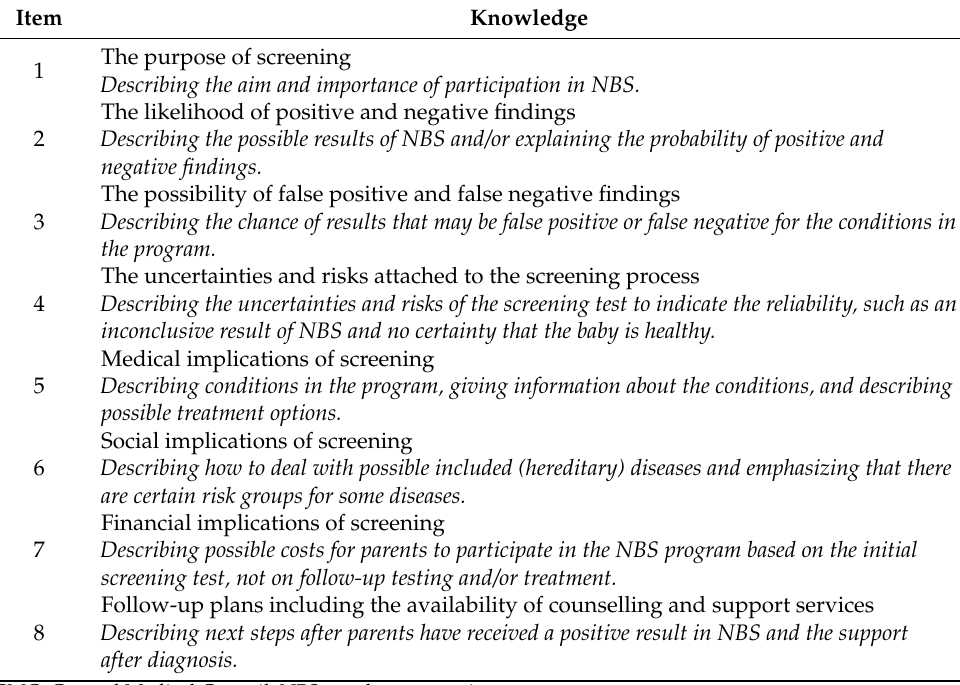
Table 1. Knowledge aspects for making an informed decision about participation in screening programs proposed by the General Medical Council (GMC) [17], and our interpretation for the analysis (in